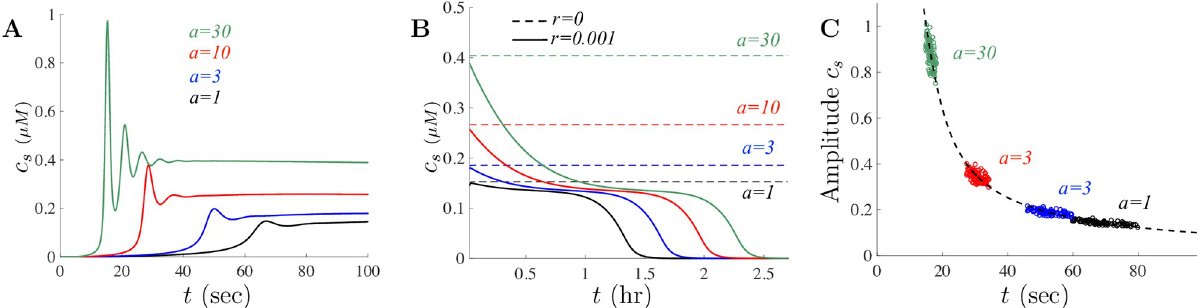
Fig 6. Amplitude and latency of model solutions vary with doses of A β . For the small doses parameters, A shows the model captures the increase in Ca 2+ signal amplitude as well as the decrease in time to peak onset. B shows the long term impact of A β for doses of A β corresponding to a = 1, a = 3, a = 10, and a = 30 in black, blue, red, and green, respectively. The dashed lines in B correspond to the steady-state values in the event where the amount of A β does not decay and is fixed. C shows the location of 100 stochastically chosen cells under the given a -value. Each color-coded circle corresponds to the location of the solution peak and time of peak when cellular parameters are varied uniformly with 10% variation for the particular a value. The dashed black curve corresponds to the location of the amplitude peak for the small doses parameters for a ranging between (0.1, 40).